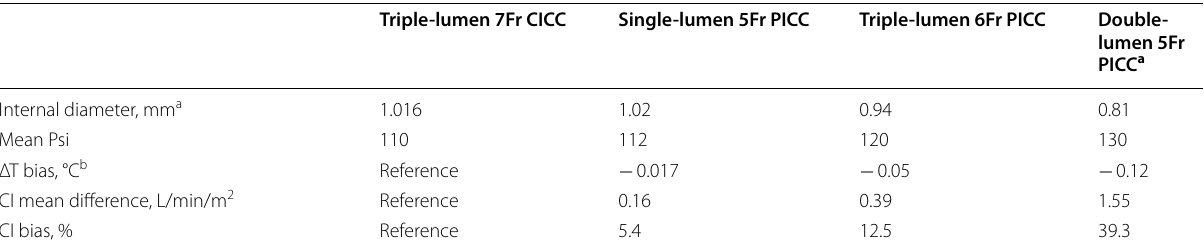
Table 6 Injection pressure, ΔT and CI during automated rapid injection through PICCs of different lumen size: comparison with CICC